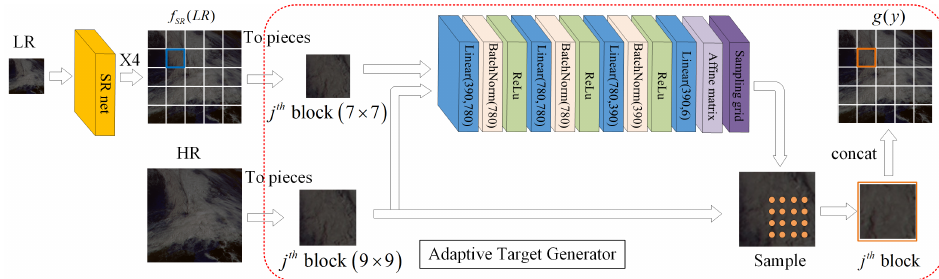
Figure 9. Structure of adaptive target generator (AdaTarget).